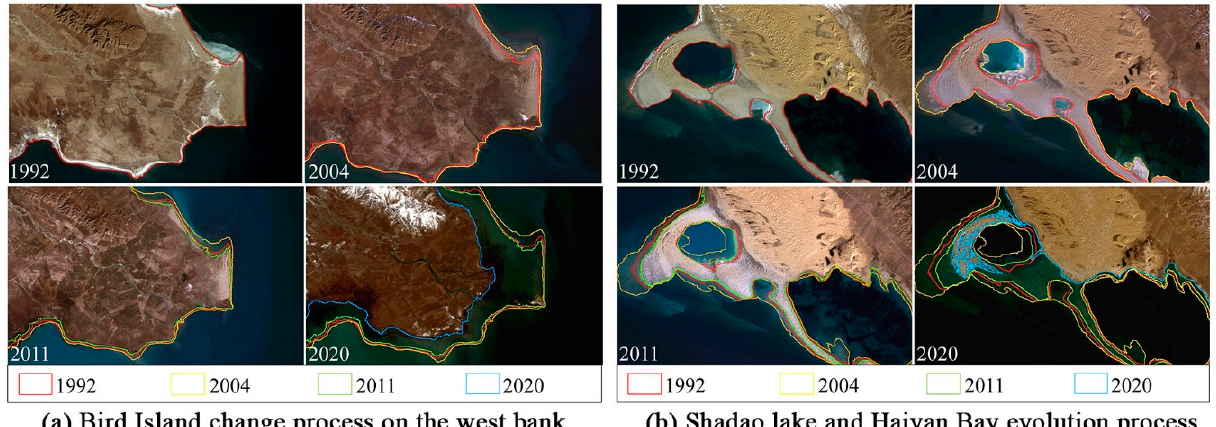
Figure 5. Shoreline change detection using Landsat images from 1992 to 2020.